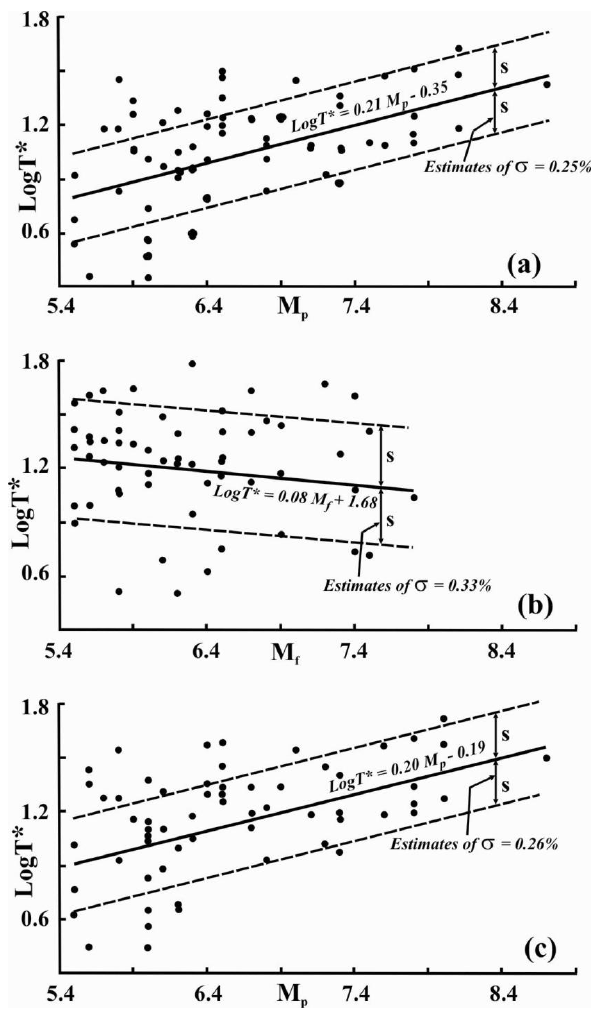
Fig. 3. Plot of T ∗ (repeat time) against M p (the preceding main- shock magnitude) and M f (the following mainshock magnitude) with their estimated regression lines (with residual, s and stan- dard deviation, σ . All earthquakes are considered in panels (a) and (b) , whereas in panel (c) , the associated aftershocks and foreshocks were